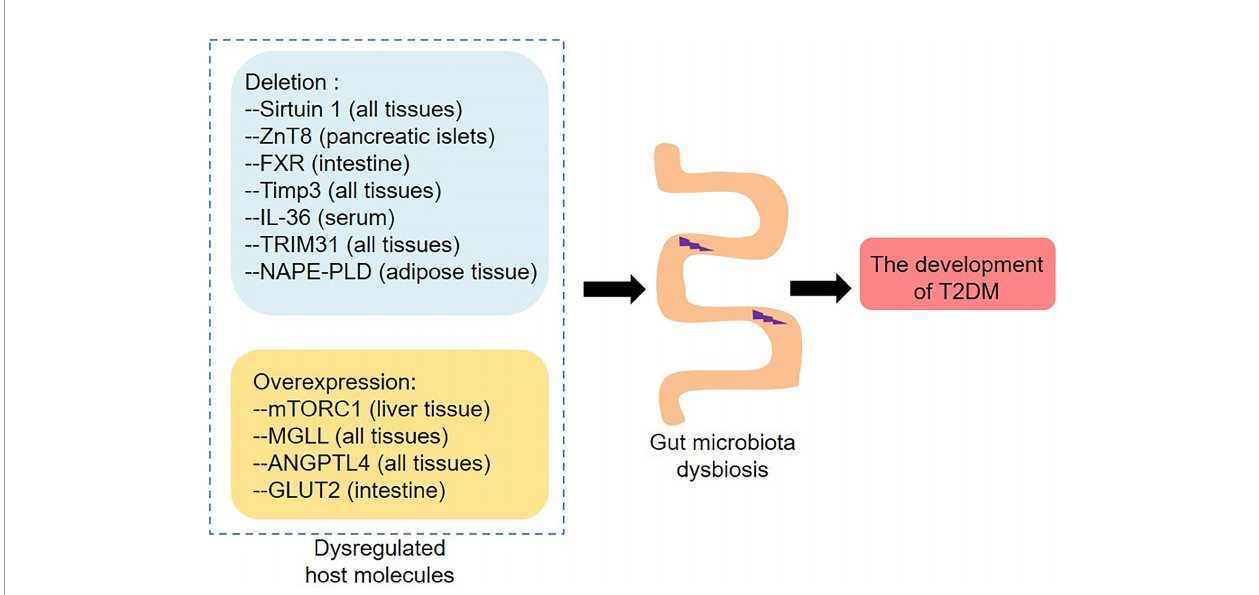
FIGURE 2 | Dysregulated host molecules change the composition of the gut microbiota and thus contribute to the development of T2DM. Deletion of Sirtuin 1, ZnT8, FXR, Timp3, IL-36, TRIM31 and NABE-PLD, as well as overexpression of mTORC1, MGLL, ANGPTL4 and GLUT2, induce gut microbiota dysbiosis. ZnT8, Zinc transporter 8; FXR, Farnesoid X receptor; Timp3, Tissue inhibitor of metalloproteinase 3; IL-36, Interleukin 36; TRIM31, Tripartite motif-containing protein 31; NAPE-PLD, N-acylphosphatidylethanolamine phospholipase D; mTORC1, Mechanistic target of rapamycin complex 1; MGLL, Monoglyceride lipase; ANGPTL4, Angiopoietin-like 4; GLUT2, Glucose transporter